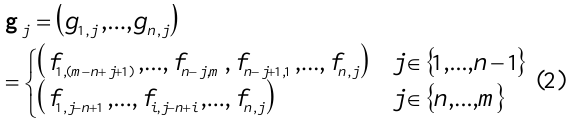
Fig. 2 shows an example of inclined vectors, where n =4 and m =9. That is to say, matrix G could be viewed as being composed by 4×9 grids, and each grid represents a symbol. To move in parallel the n ( n -1)/2 grids on the upper-right corner of G to the left, then the inclined vectors g ,…, g are shown by oblique lines in 1 m Fig.